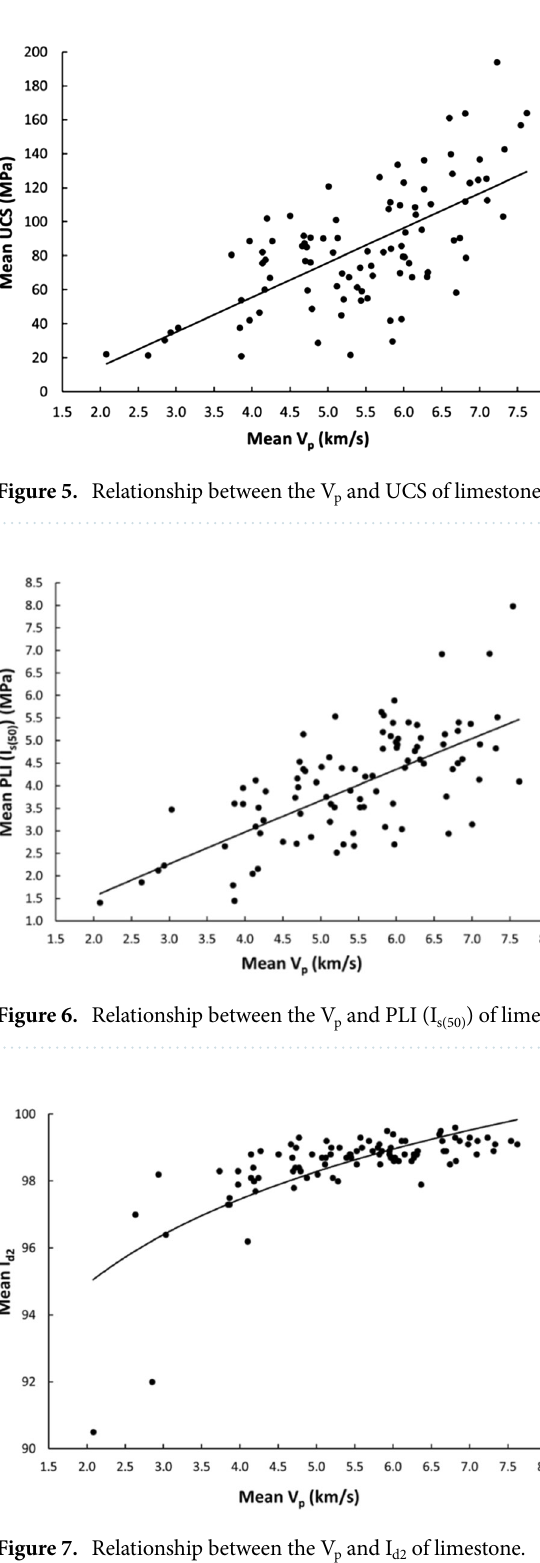
Figure 7. Relationship between the V p and I d2 of